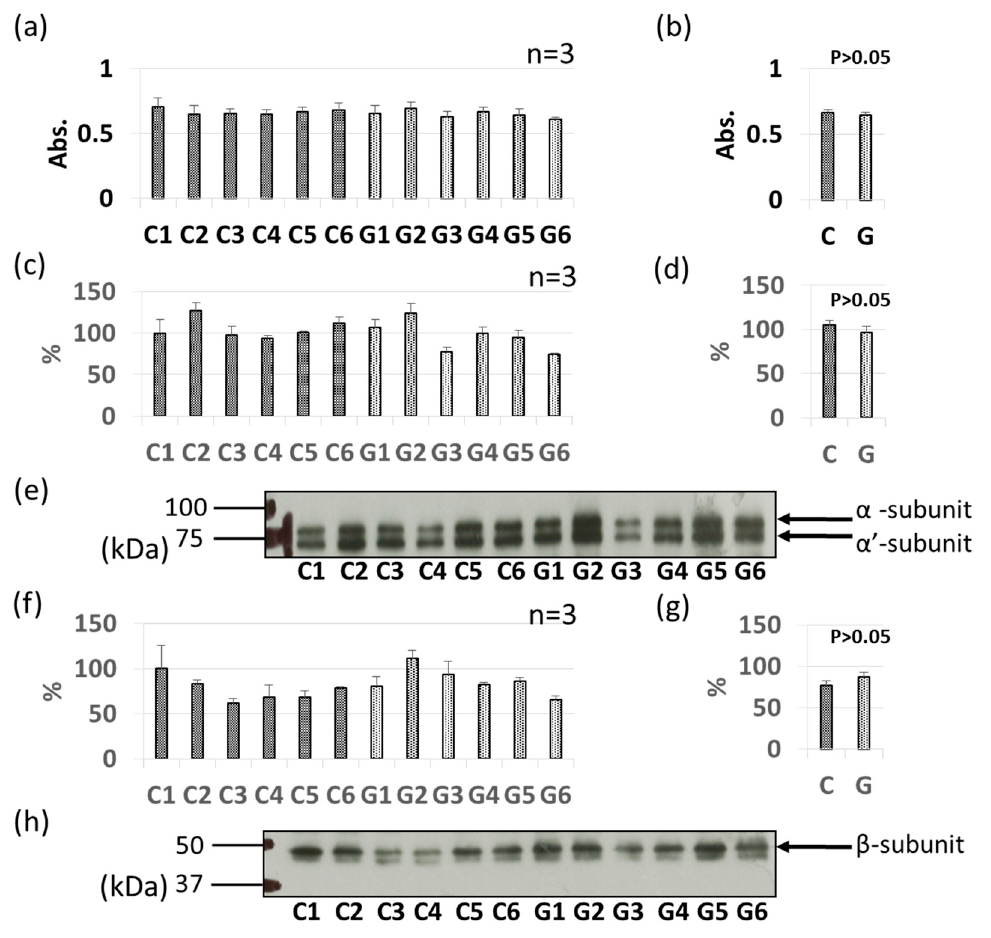
Figure 7. Comparison of Gly m 5 levels in GM-and non-GM soybeans by ELISA ( a,b ) and immunoblotting ( c–h ) using rabbit-derived polyclonal antibodies . Soybean protein extracts were evaluated by ELISA (a,b) and immunoblotting (c–h) for detection of Gly m 5 levels. The ELISA data are presented in absorbance values (Abs). The α - and α ’-subunits of Gly m 5 were detected (c–e) separately from the β -subunit of Gly m 5 (f–h) . The individual data from six GM-and non-GM soybeans (a–f) are presented as the mean ± SD of three independent replicates. The collated data (b,d,g) are presented as the mean ± SD of all individual data points from the control (C1–C6, six non-GM soybeans) or experimental (G1–G6, six GM soybeans) groups relative to the value of control number 1 (C1). Representative immunoblots are also provided (e,h) .